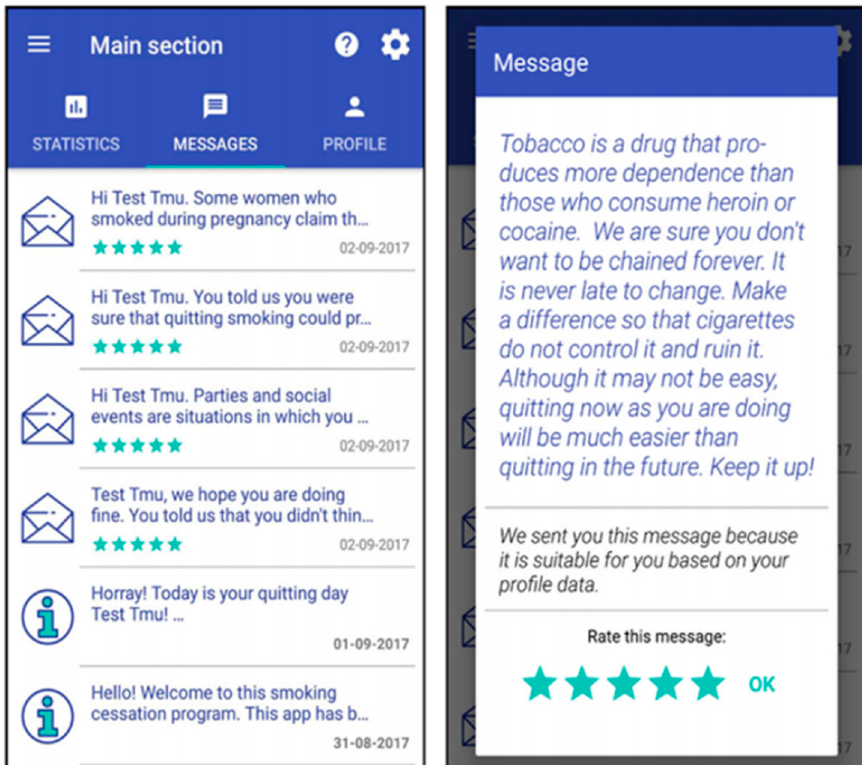
Figure 1. English version of the mobile app interface.